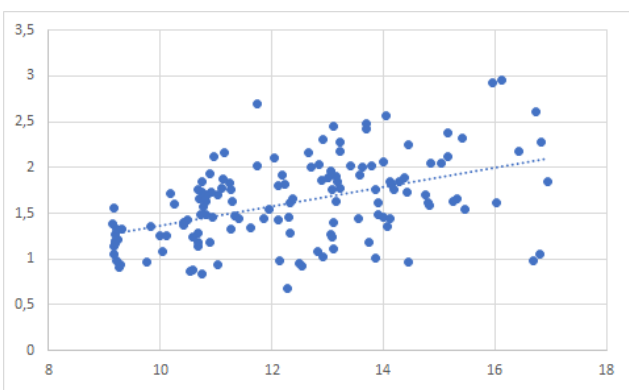
Figure 15. The correlation between RMSE and the standard deviation: the RMSE ( X -axis) and the standard deviation ( Y